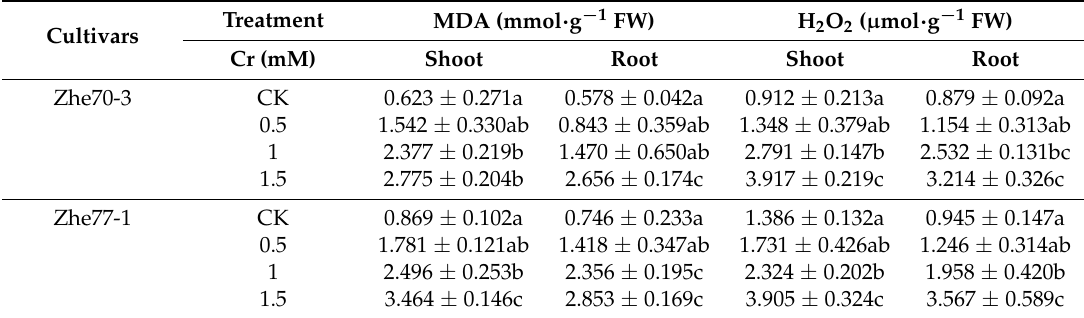
Table 3. Effects of Cr treatments on MDA and H 2 O 2 contents in shoot and root of kenaf cultivars Zhe70-3 and